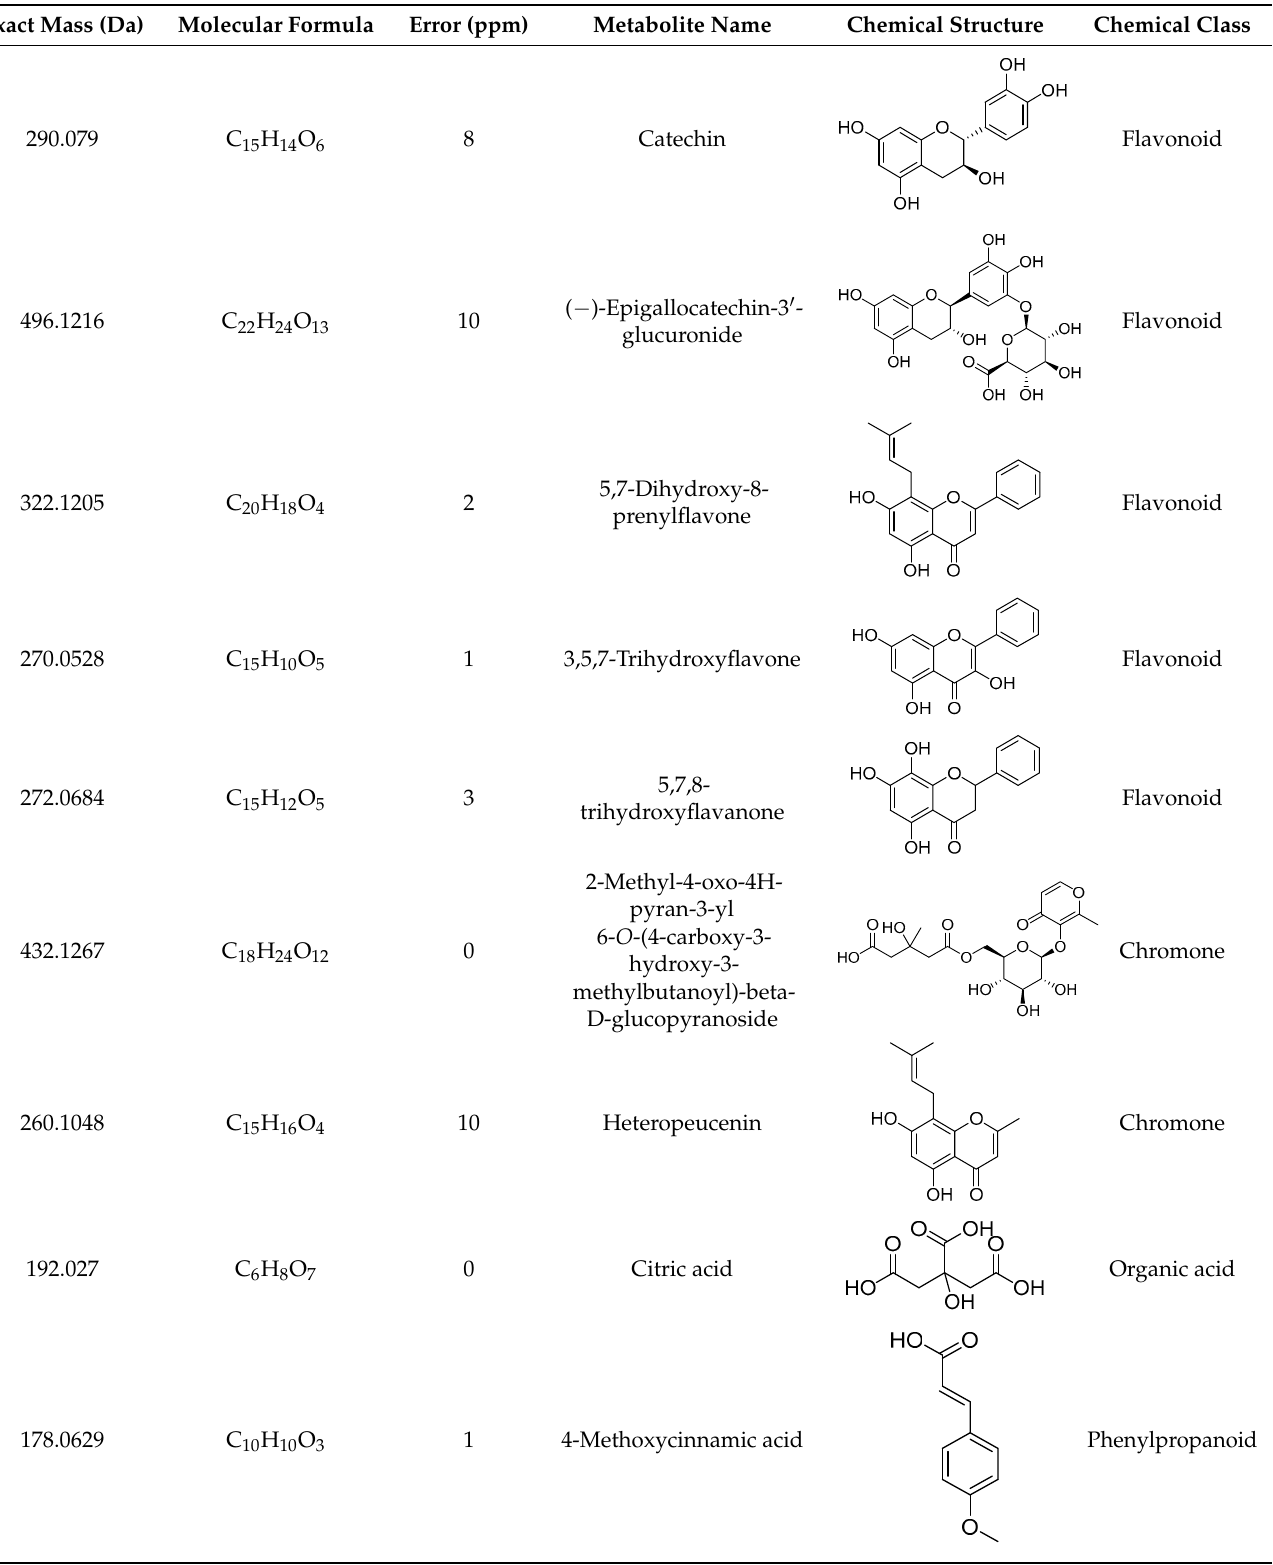
Table 1. Results of the metabolite annotation of cupuassu ( T. grandiflorum ) through LC-HRMS/MS analysis in positive ion mode ESI.